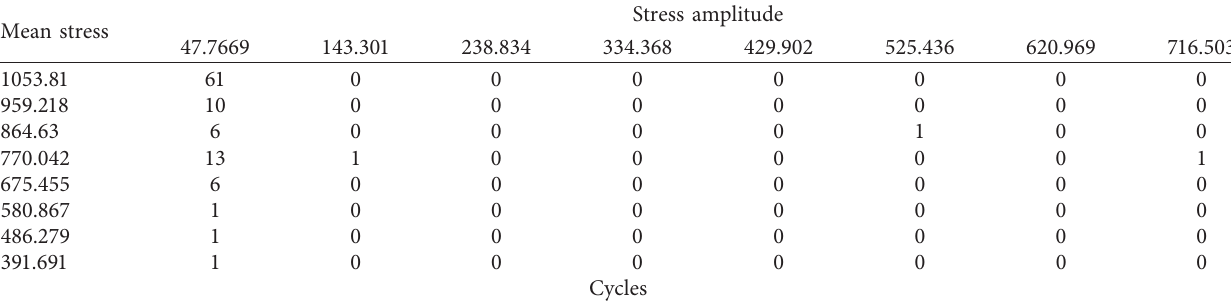
Table 5: Stress spectrum at point P1 of recoil spring (unit: MPa).